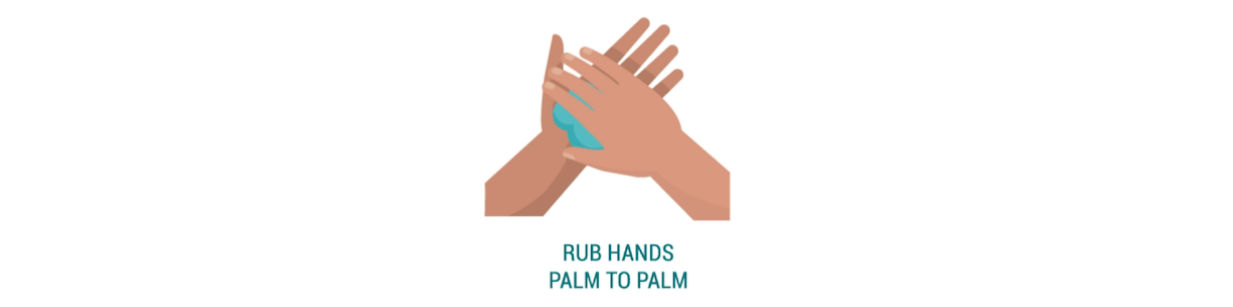
Figure 4. Control condition.